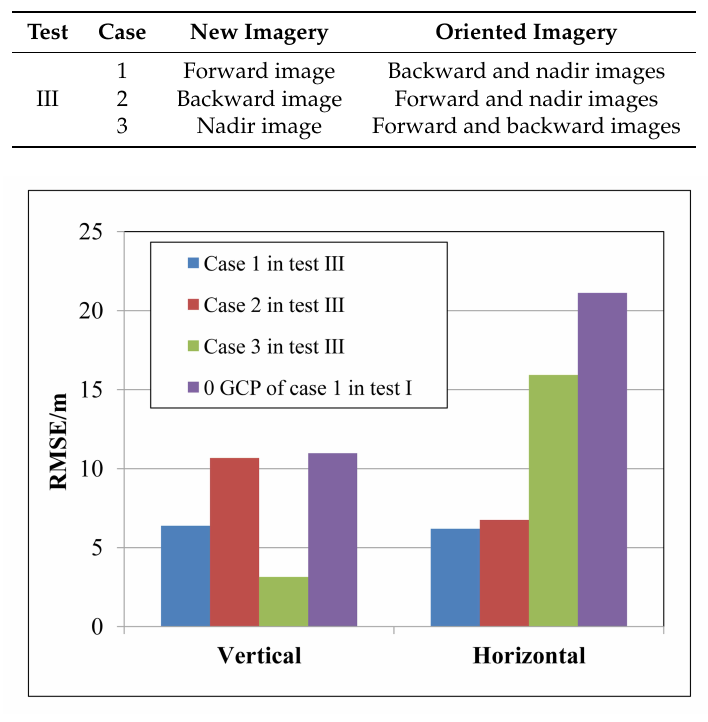
Table 8. ZY-3 datasets for direct georeferencing with the oriented imagery.